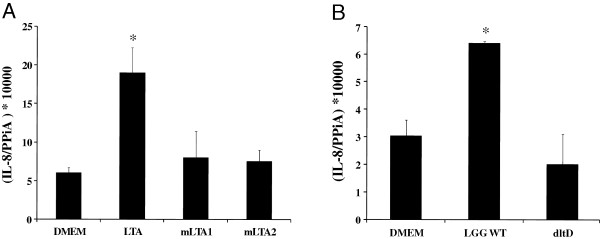
Interleukin-8 mRNA response of human Caco-2 cells to 1.5 h stimulation with various compounds. Cells were stimulated with LGG LTA, mLTA1 and mLTA2 (10 μg/ml) (panel A) or with live LGG WT or the dltD mutant strain (panel B) for 1.5 hours. DMEM medium served as a negative control. Bacteria were administered at 107 CFUs per ml. The results shown are representative for at least three independent experiments. Data represent mean values ± SD. *p-value < 0.05 compared to the negative control (DMEM).